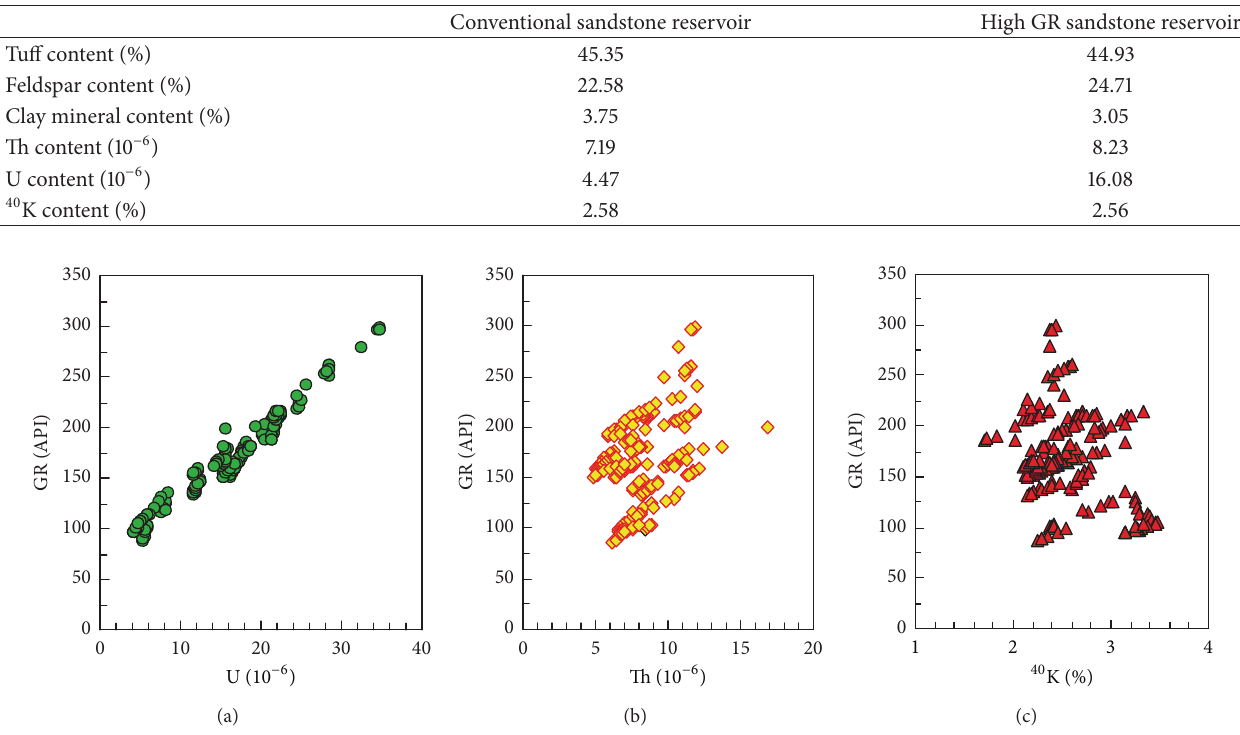
Figure 3: Cross plots of GR value versus (U), thorium (Th), and potassium ( 40 K), respectively.